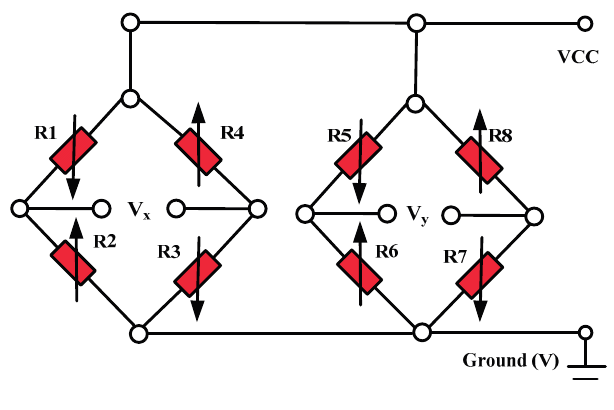
Figure 5. Scheme of the Wheatstone